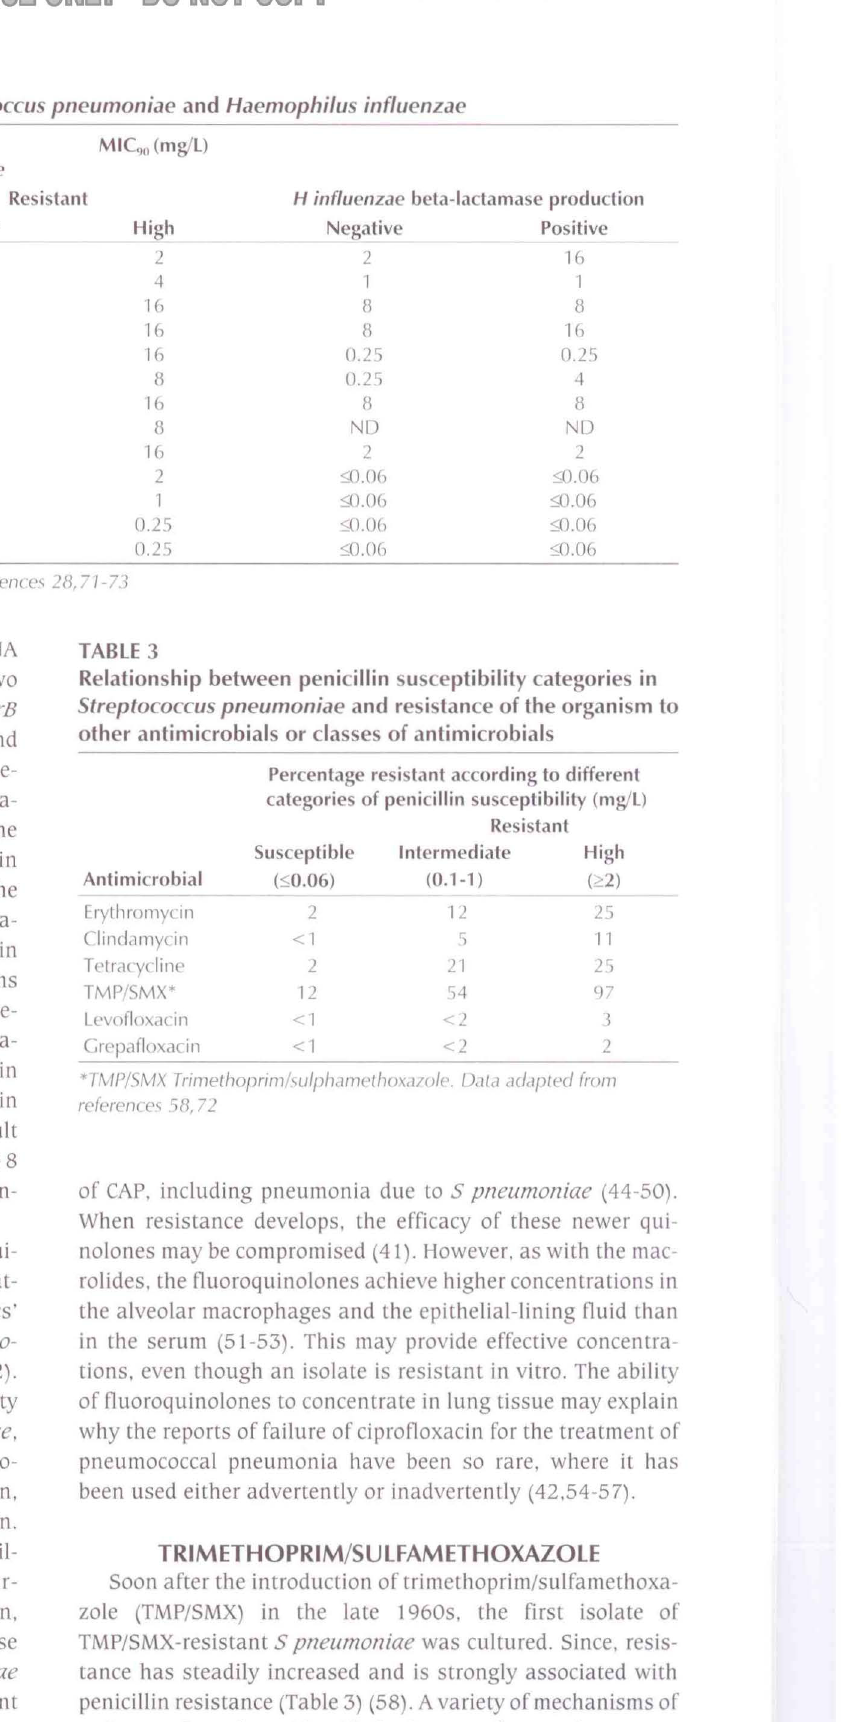
MIC.,o (mg/L) S pneumoniae Resistant H inf/uenzae beta-lactamase production